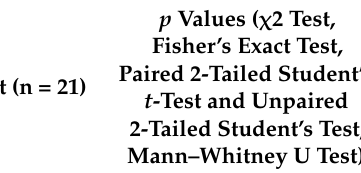
Table 2. Distribution of change in ODI, stratified by EBM concordant degenerative